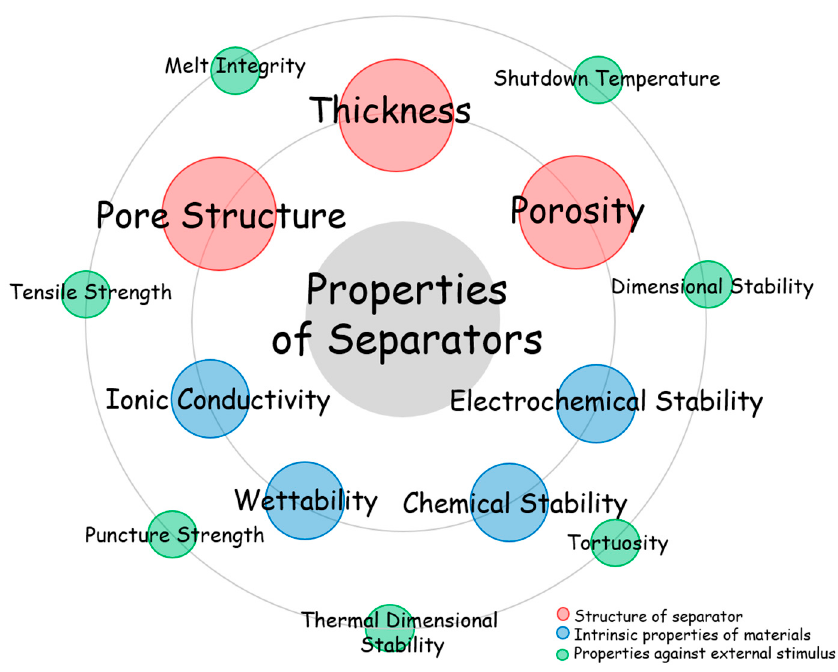
Figure 1. Illustration of the key properties of separators.